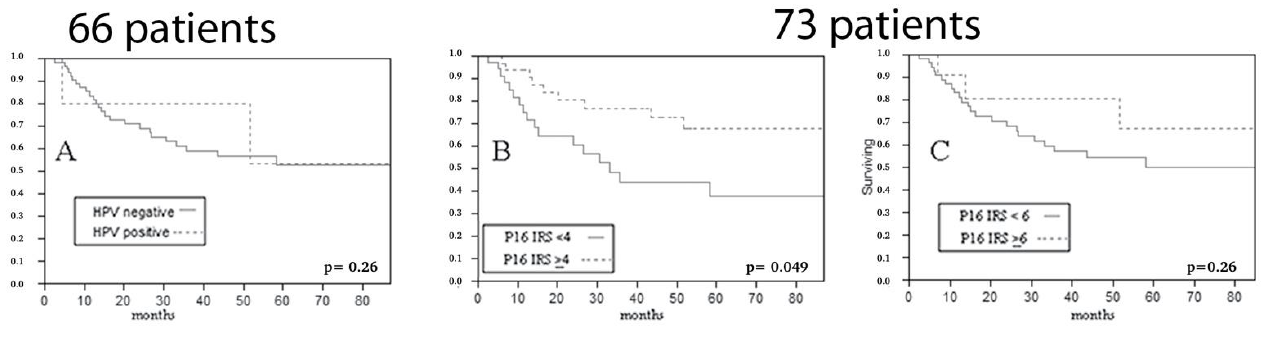
Figure 5. Impact of HPV DNA (( A ) p = 0.26 at Log-Rank) and of p16 expression (( B ) IRS ≥ 4 cut-off p = 0.049 at Log-Rank; ( C ) IRS ≥ 6 cut-off p = 0.26 at Log-Rank) on relapse free survival of primarily operated patients (HPV DNA was available in 66 cases, p16 IHC in 73).